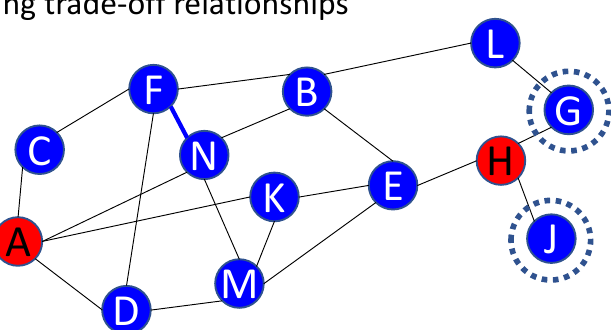
Figure 9. Two basic searches ( a ) network search and ( b ) path search, and search for avoiding trade-offs ( c ), which can be realized by combining path search and network search.